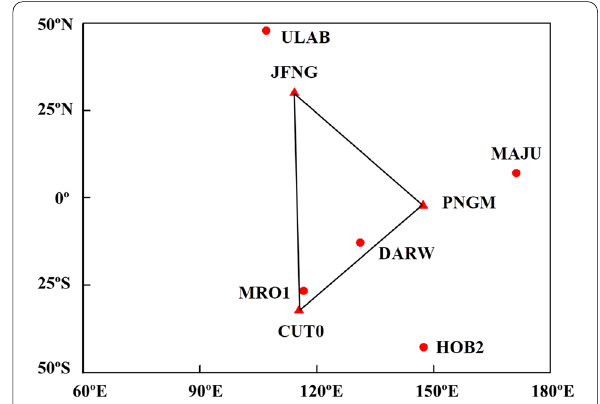
Fig. 1 Locations of the three reference stations (marked as triangles) and five user stations (marked as circles). All stations can track the BDS C01 satellites. In total, eight to ten BDS satellites were observed during the data collection period